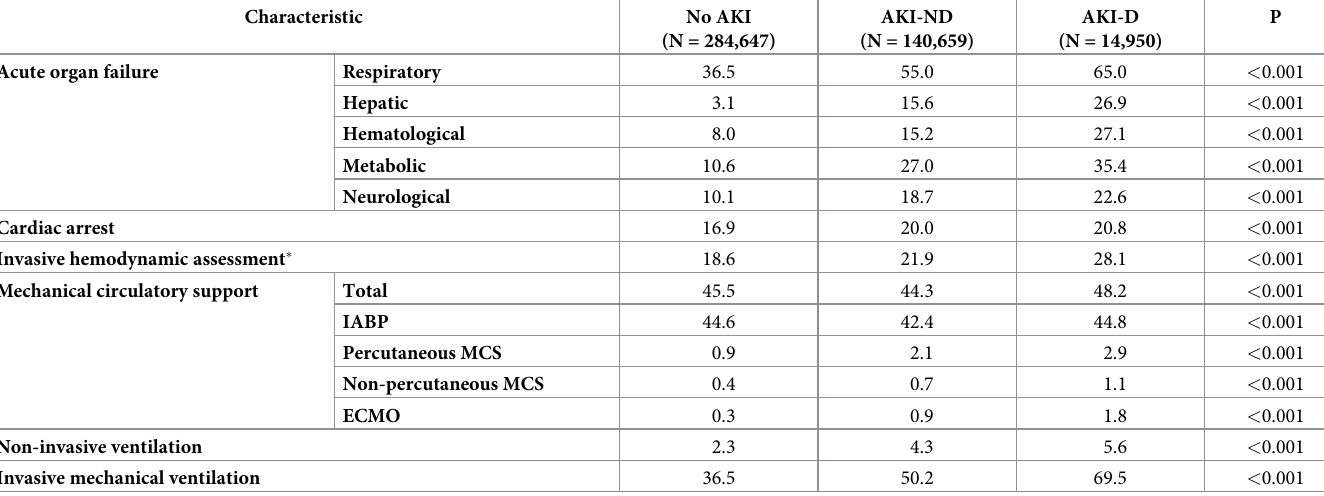
Table 1. Organ failure and management of AMI-CS with and without acute kidney